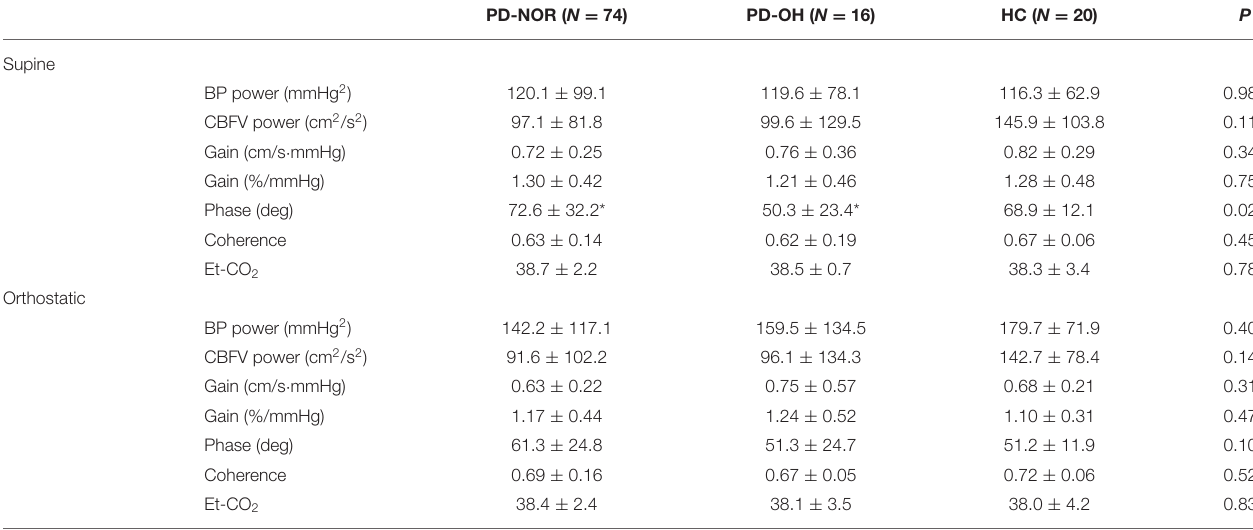
TABLE 4 | Cerebral autoregulation parameter in patients with PD with or without OH.